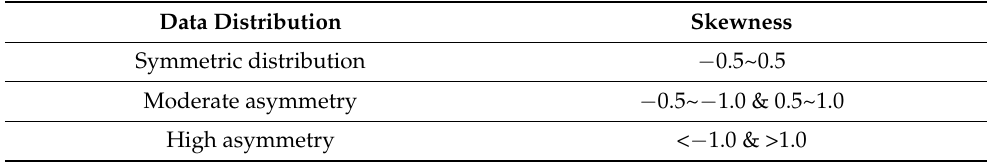
Table 1. The relationship between data distribution and skewness. Data